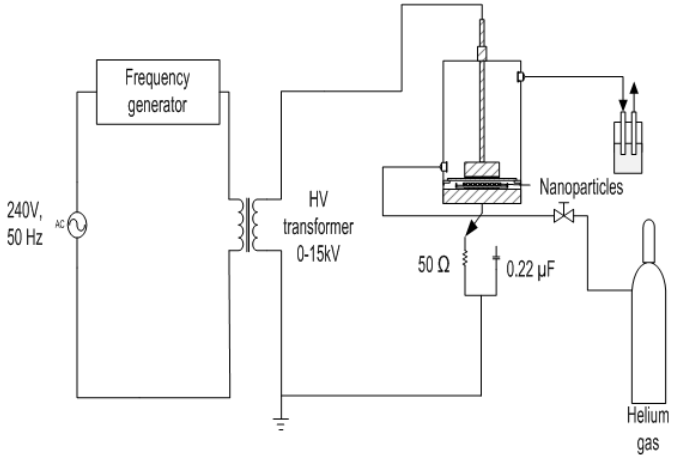
Figure 2. Experimental setup for the plasma treatment.